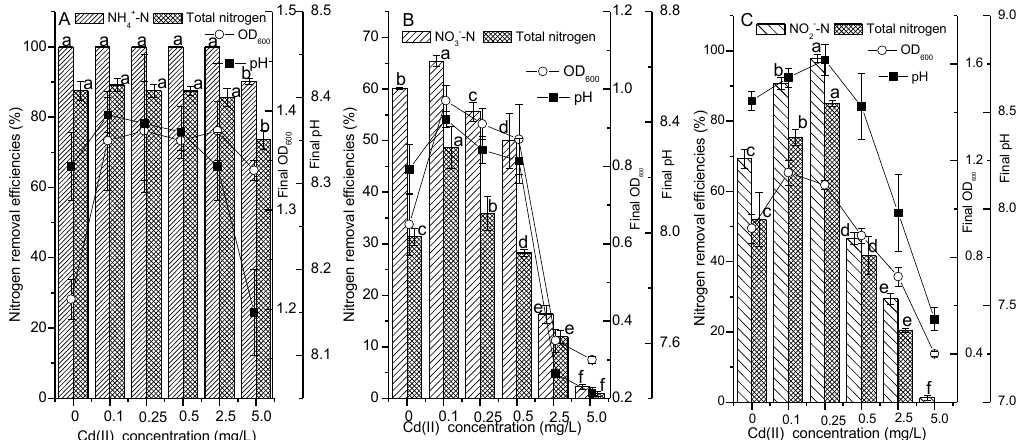
Figure 1. Effects of Cd(II) on ammonium, nitrate, and nitrite removal abilities of strain Y-10. ( A ) ammonium; ( B ) nitrates; ( C ) nitrites. The values shown are the means ± the SD (Standard Deviation) of the results of three replicates (error bars). Different letters indicate a significant difference between treatments at p < 0.05. OD 600 : the optical density at 600 nm.